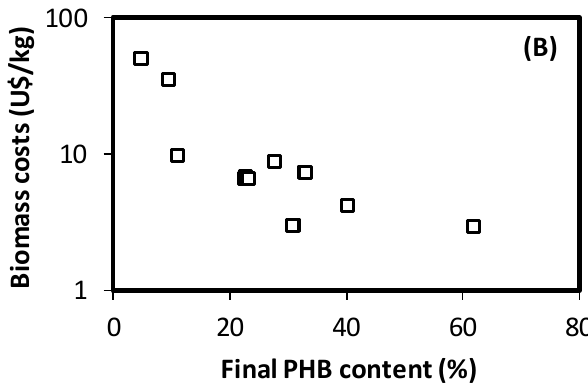
Figure 5. Cost estimation for production of PHA-enriched biomass as a function of ( A ) the total biomass productivity and ( B ) PHB content by the end of the cycle.